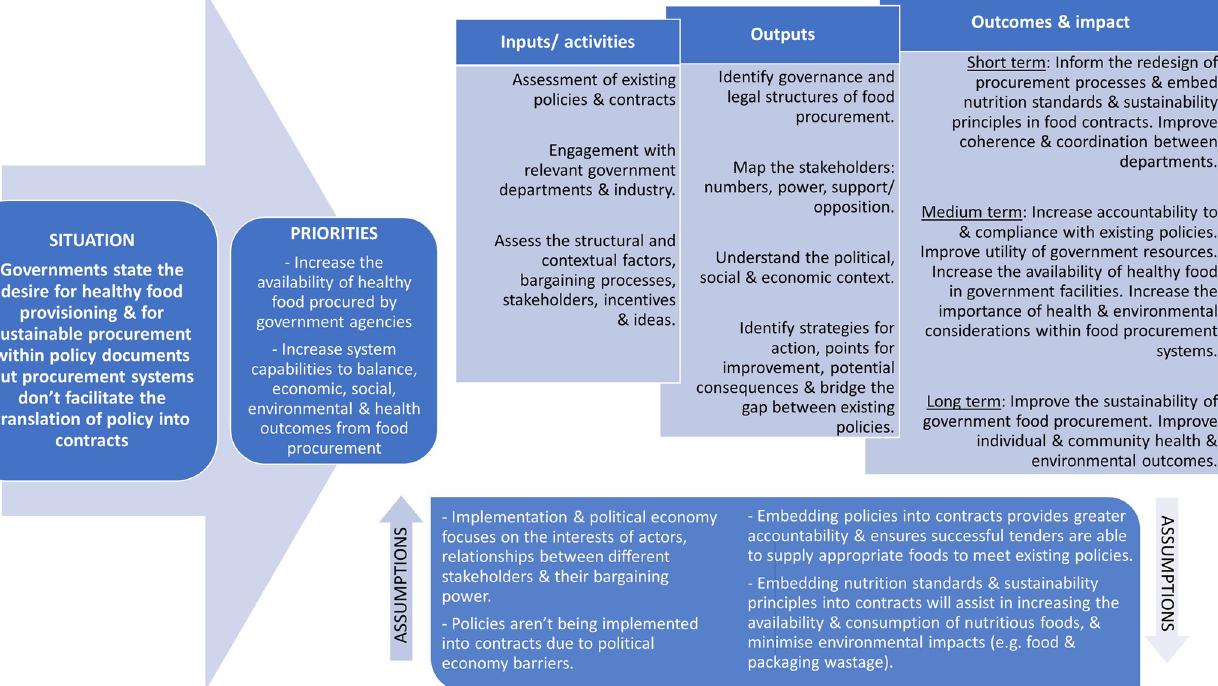
PLOS ONE | https://doi.org/10.1371/journal.pone.0274246 September 9,